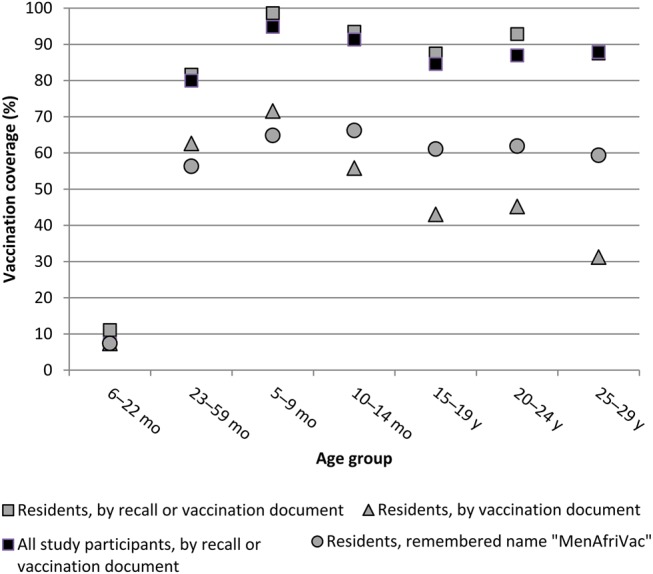
Age-specific vaccination coverage with meningococcal group A conjugate vaccine in Bobo-Dioulasso, Burkina Faso, 2011. Estimates are given for all study participants, and specifically for participants who were residents of Bobo-Dioulasso in 2010 according to different information types.